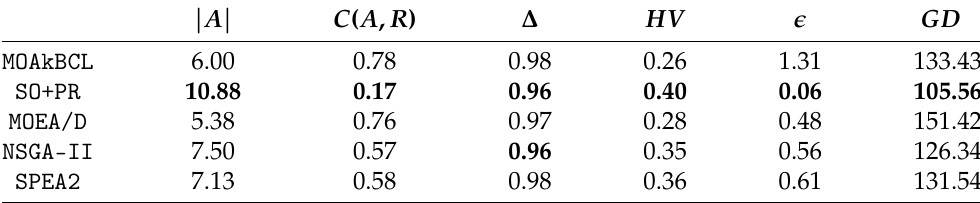
Table 3. Average results for the k -BLC 123 on the WorkSpace and Large-scale instances. BCL— Balanced Center Location; SO—Strategic Oscillation; PR—Path